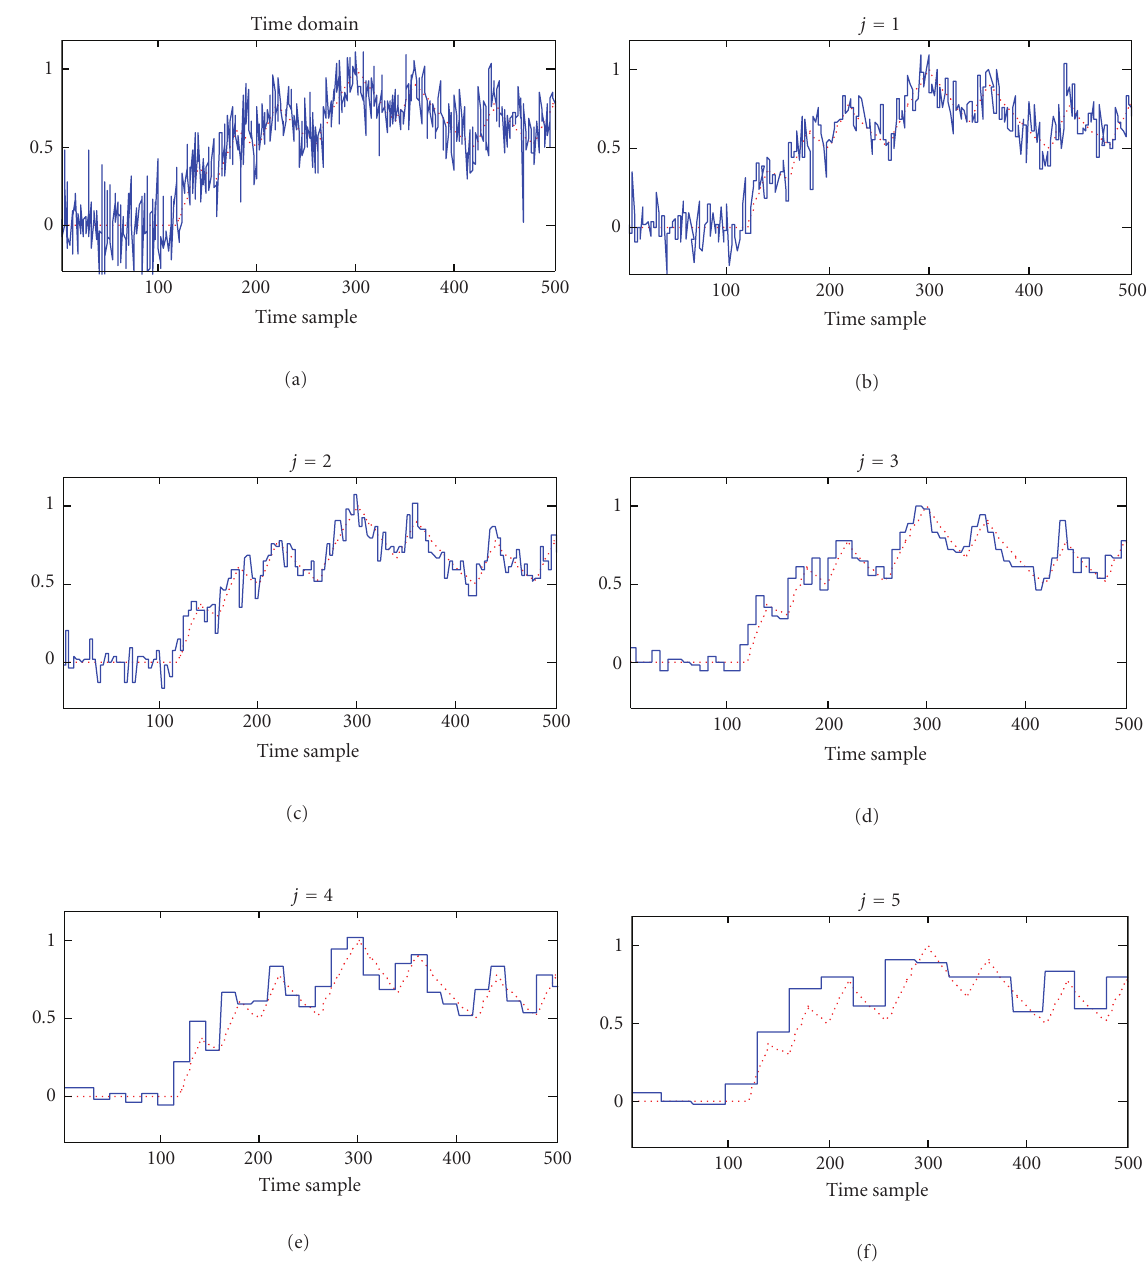
Figure 5: MSNL modeling performance at multiple scales, where σ ε = 0 .